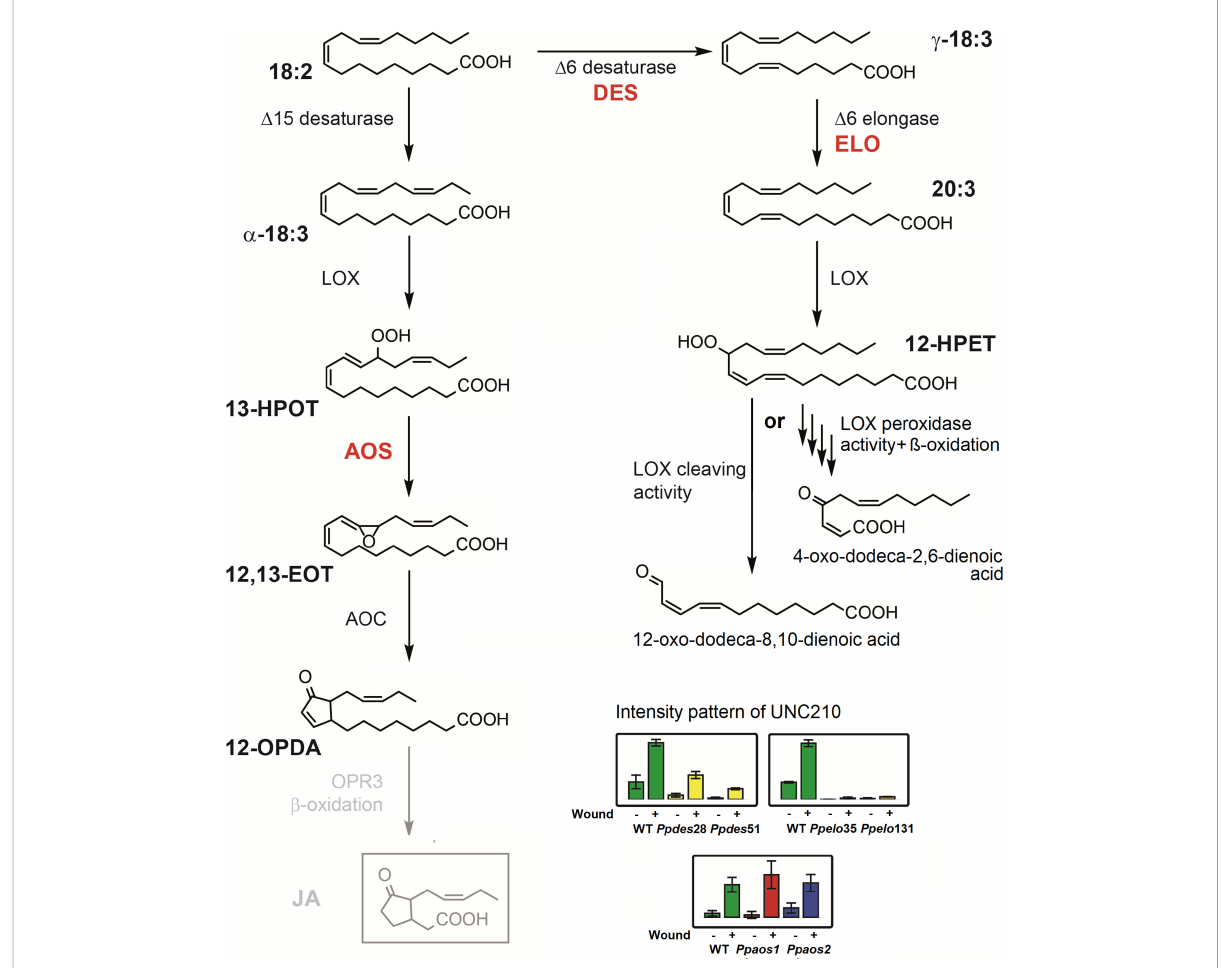
FIGURE 4 Possible pathways for the synthesis of UNC210 in response to wounding stress in P. patens . The compound with the mass of 210.1256 Da was detected in P. patens , but did not coelute with JA-standard. The intensity pattern of the compound is depicted for three separate wounding experiments (see Figure 2) as bar diagrams with the genetic backgrounds WT (green bars), Ppdes 28 and 51 (Girke et al., 1998) (yellow bars), Ppelo 35 and 131 (Zank et al., 2002) (orange bars), Ppaos1 (red bars) and Ppaos2 (blue bars). For each genotype, the left bar represents control samples and the right bar represents wounded samples. UNC210 accumulated strongly in wounded WT, Ppaos1 and Ppaos2 samples, while accumulation in wounded Ppdes lines was reduced. In Ppelo lines, the compound was not detected. Since the compound was still formed in Ppaos1 or Ppaos2 mutants, it cannot derive from OPDA as JA does. We therefore suggest two alternative possible structures for UNC210 that derive from the catalytic activity of PpELO and PpLOX1 or 2 on C20